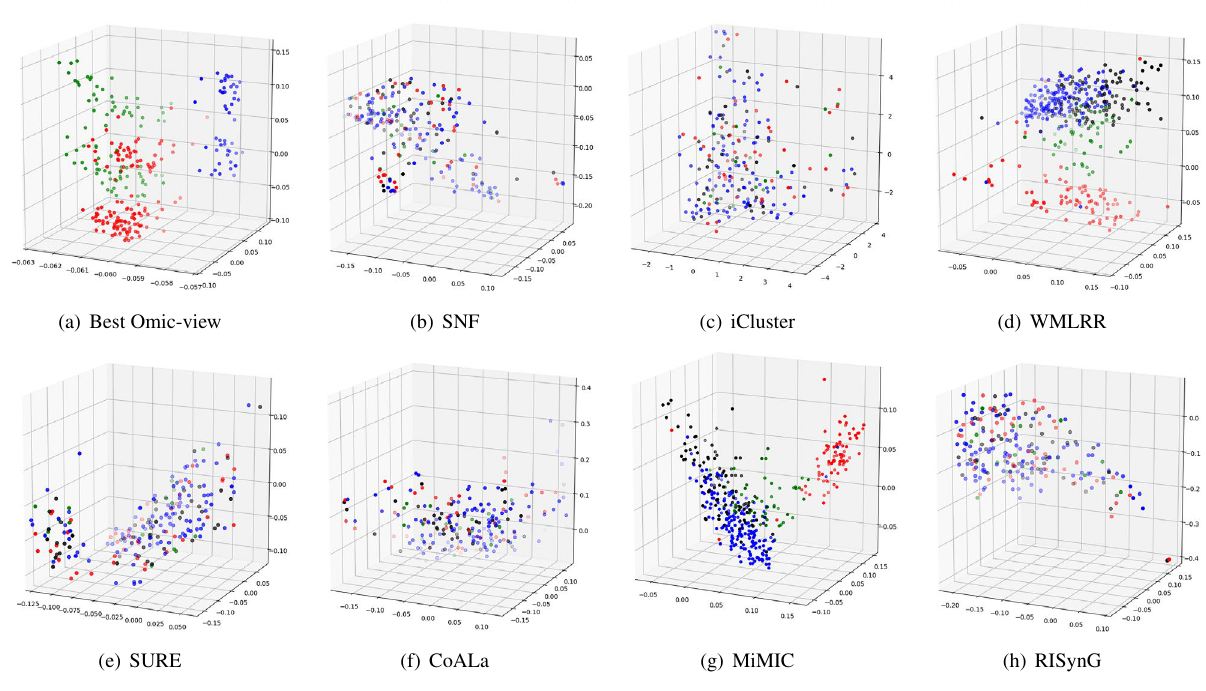
Figure 4. Comparative analysis of different integrative sub-spaces for BRCA